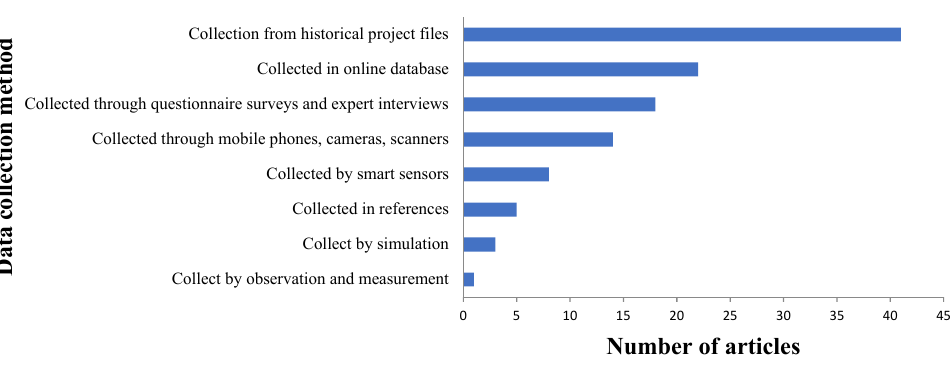
Figure 7. Data source of ANN application in CM.